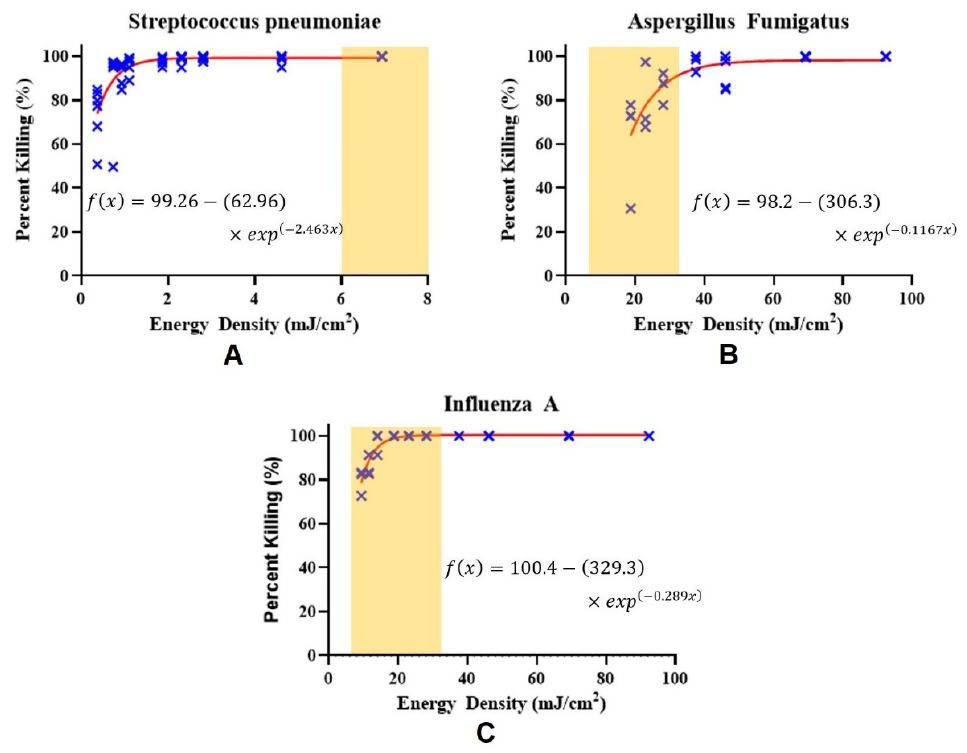
Figure 6. The percentage of bacteria killing rate as a function of UVC LED energy density . ( A ) S. pneumoniae , ( B ) A. fumigatus , and ( C ) influenza A . The yellow highlighted region shows the range of UVC light energy the device delivered to the surface, as described in detail in Section 3.2.